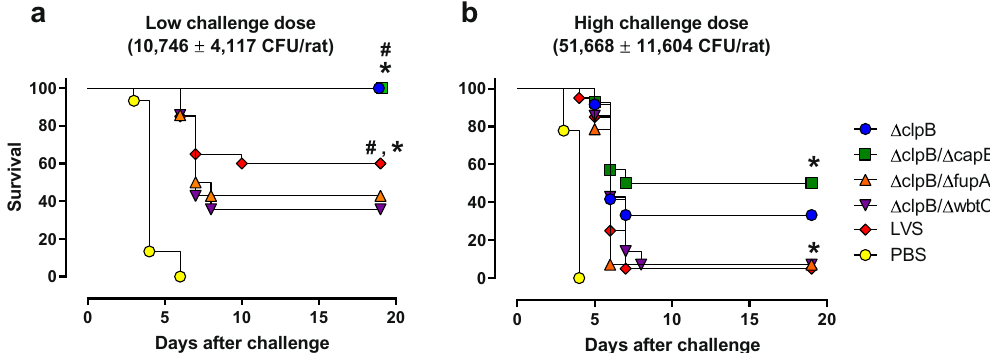
Fig. 6 Survival outcomes after aerosol challenge with SchuS4 of vaccinated rats re fl ect in vitro activities of leukocytes. Fischer 344 rats were vaccinated as indicated. Six weeks after vaccination, rats were challenged by aerosol either with a high ( b ) or low ( a ) dose of SchuS4. Survival was monitored for 28 days. The experiment was repeated three times with various combinations of the vaccines for a total of 8 – 20 animals per vaccine-challenge dose group. For each challenge dose, bacterial lung deposition was monitored and was comparable across the three experiments. The fi gure depicts the time to death and survival of results combined from all three experiments. # and * indicate signi fi cant differences between survival outcomes for Δ clpB - and LVS-vaccinated rats, and between survival outcomes for Δ clpB- Δ capB - and LVS-vaccinated rats, respectively, calculated by Kaplan – Meier and log-rank (Mantel – Cox)